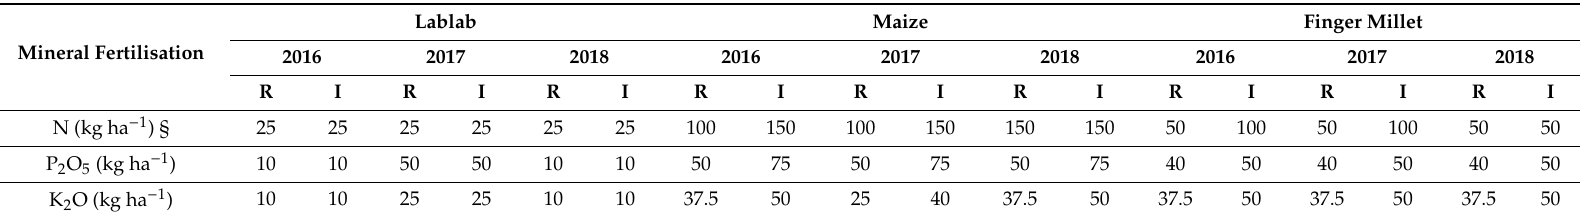
Table A2. Nitrogen (N), phosphorous (P 2 O 5 ) and potassium (K 2 O) application rates to lablab, maize and finger millet crops in rainfed (R) and irrigated (I)